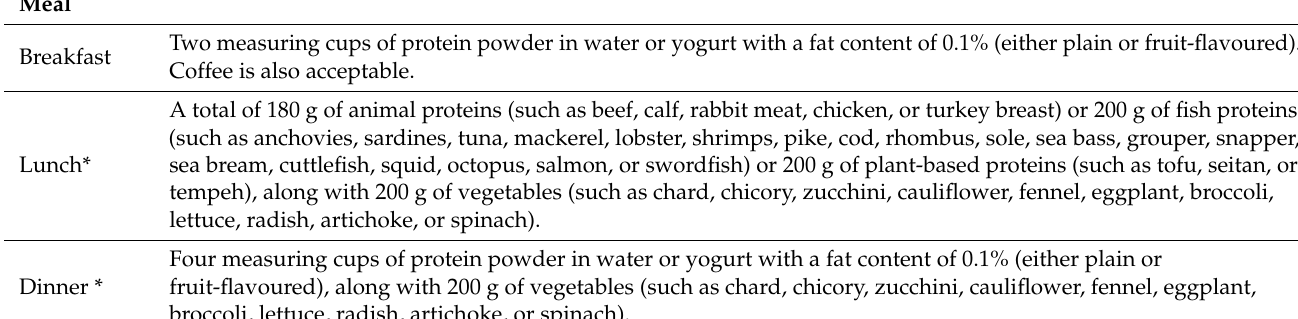
Table 2. Very low-calorie ketogenic diet scheme used by Albanese et al. [36].